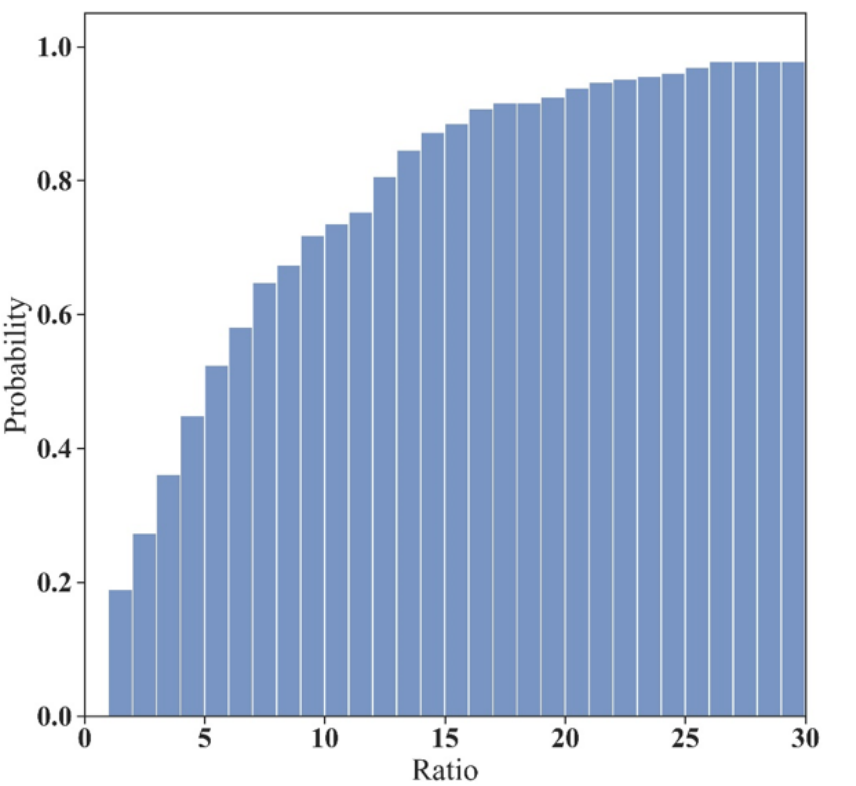
Figure 9. Surface runoff ratios between full agricultural conservation practice adoption and the default conventional tillage scenario. The histogram bars represent the cumulative probability that a value falls at or below the respective ratio.